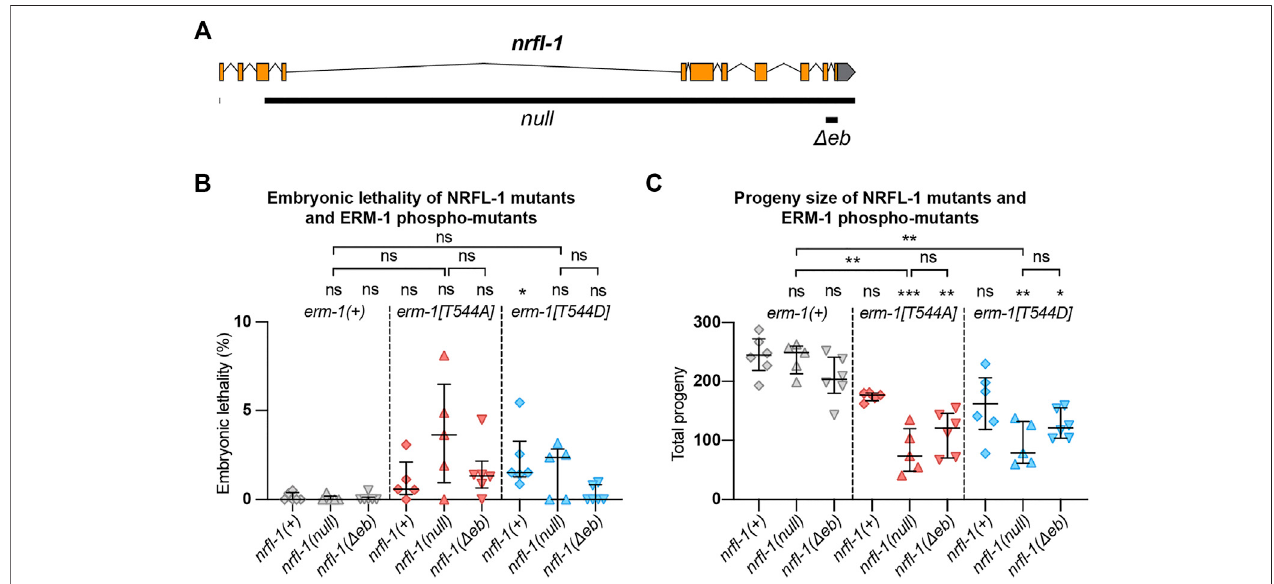
FIGURE 3 | NRFL-1 cooperates with ERM-1 C-terminal phosphorylation. (A) Gene model for nr fl -1a . Orange boxes represent exons and lines represent introns. Greyboxrepresents3 ′ untranslatedregion.Blackbarsdenotetheregionsdeletedin null and Δ eb alleles. (B,C) Quanti fi cationofembryoniclethality (B) andtotalprogeny (C) from parents of indicated genotypes. Each data point represents the embryonic lethality (B) or progeny (C) of a single animal; N (cid:1) 5 or 6. Error bars: mean ± SD. Statistical test: Kruskal-Wallis test with Dunn ’ s multiple comparison correction.